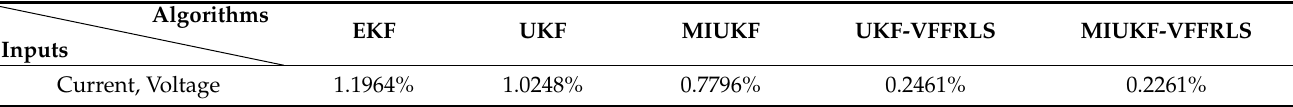
Table 5. The MAE of Kalman filtering framework algorithms.